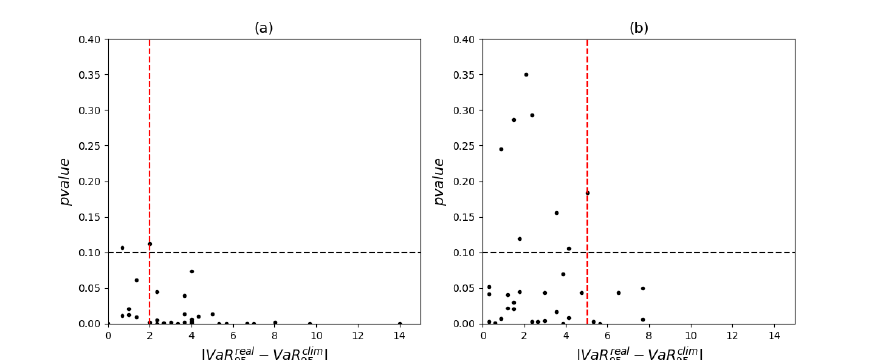
Figure A3. p -value resulting from the 2 dimensional Kolmogorov-Smirnov test performed between the climatological sample and the seasonal samples as a function of the absolute difference between the VaR real and VaR clim . Black dashed line represents the 10% significance level for which the hypothesis 95 95 of 2 samples coming from the same distribution cannot be rejected; Red dashed lines represent the threshold defined; ( a ) for winter, ( b ) for